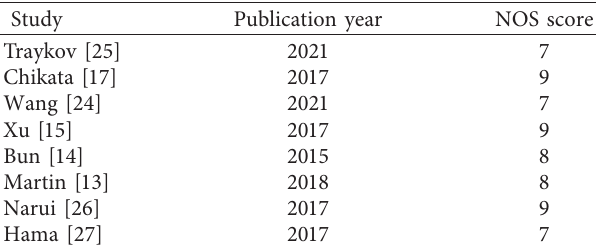
Table 1: Quality assessment of observational